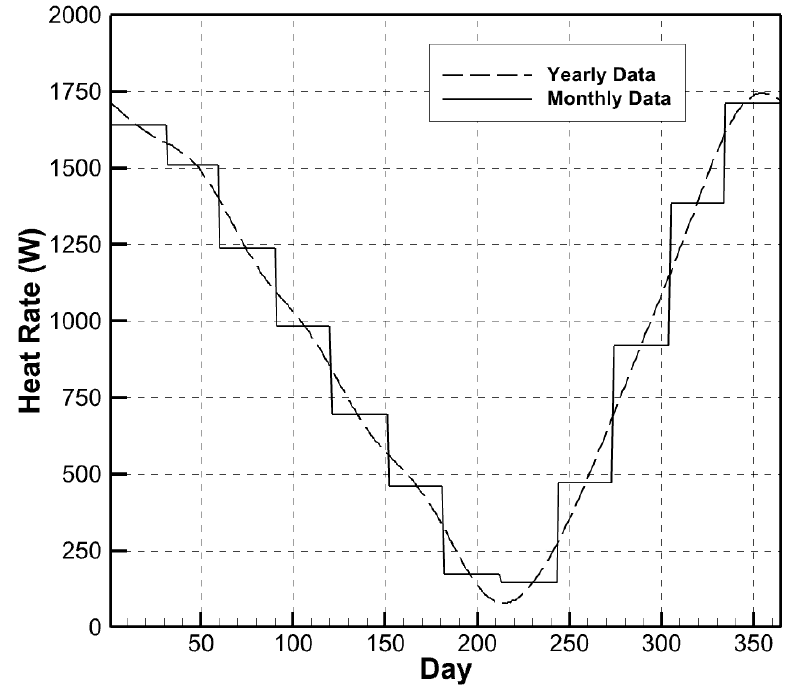
Figure 1. Comparison of wall heat rates using yearly and monthly data. The rate of the heat lost through the walls and windows was solved in the simulations. Figures 2 and 3 show these heat rates when aerogels were used versus standard insulation.